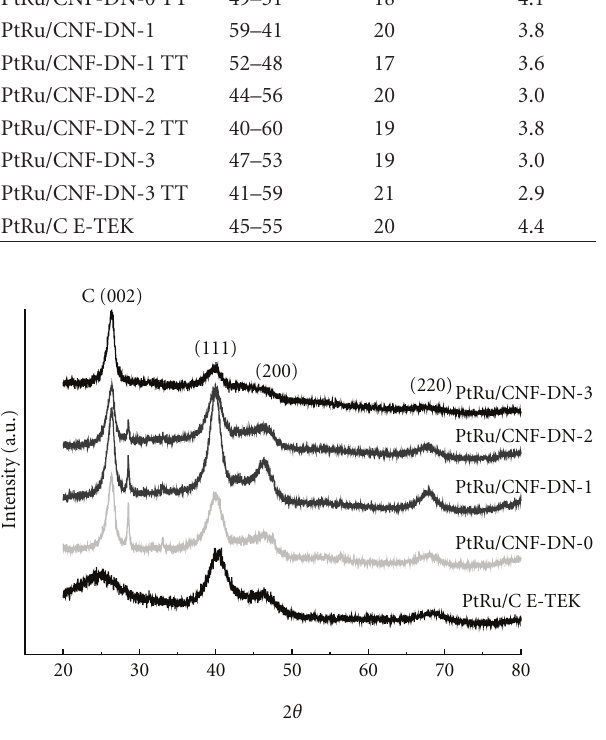
Figure 1: XRD di ff ractograms for the untreated Pt-Ru catalysts.